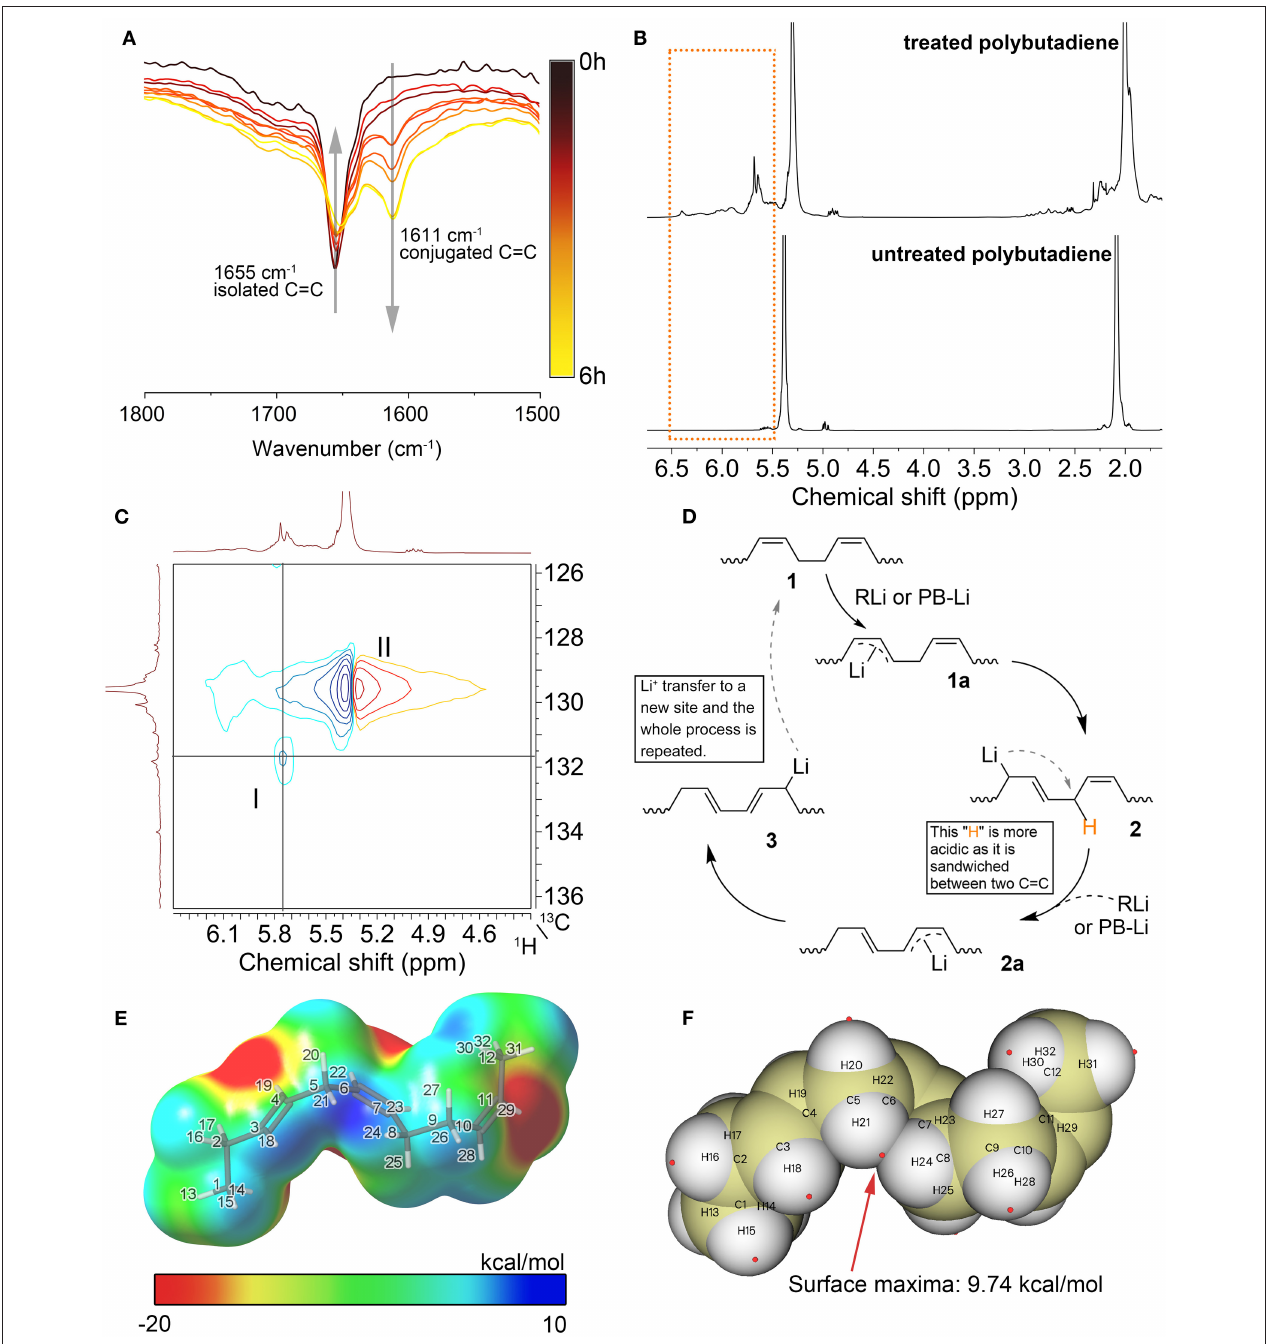
FIGURE 1 | (A) FTIR spectra of treated polybutadiene with different reaction times. (B) 1 H NMR spectra for PB and its rearrangement product. Reaction condition: 1h, 80 ◦ C, in n-hexane, TMEDA/n-BuLi = 1:1, the molar ratio of n-BuLi to C = C is 1:1. (C) 2D 1 H- 13 C HSQC NMR of treated polybutadiene. The reaction condition is the same as before. (D) Proposed reaction mechanism. (E) ESP mapped van der Waals surface for the model of key intermediate. (F) Distribution of ESP maxima (red spheres) on the van der Waals surface of the model. Preparation and analysis procedures for samples in this figure are given in Supplementary Material